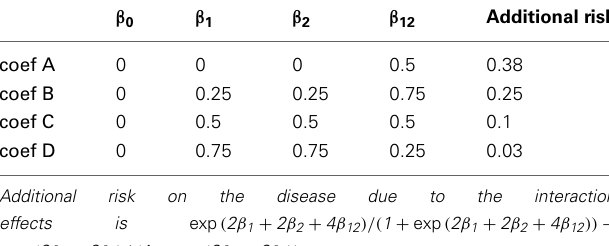
Table 2 | Coefficients for simulation